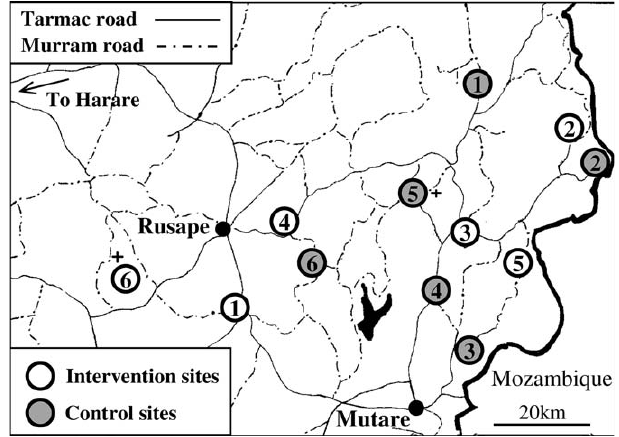
Figure 1. Location of Intervention and Control Communities in Manicaland Province, Eastern Zimbabwe